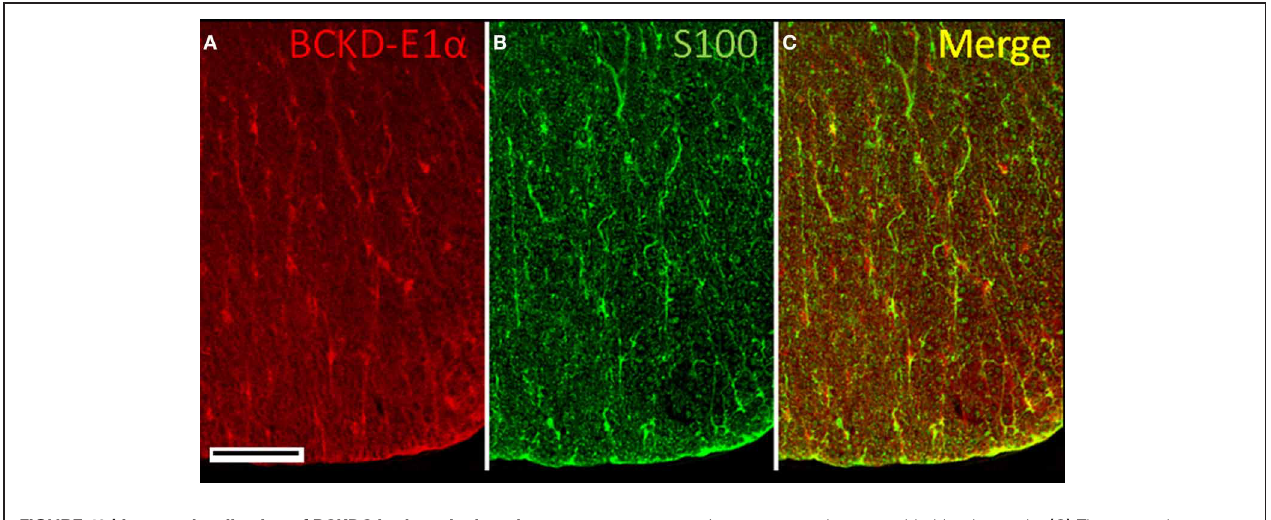
FIGURE 10 | Immunolocalization of BCKDC in the spinal cord. (A) Labeling for BCKDC in the white matter is found on cell bodies and fine, radially oriented processes. (B) Labeling for an astrocyte marker, S100, is present over some cell bodies, but is mostly associated with